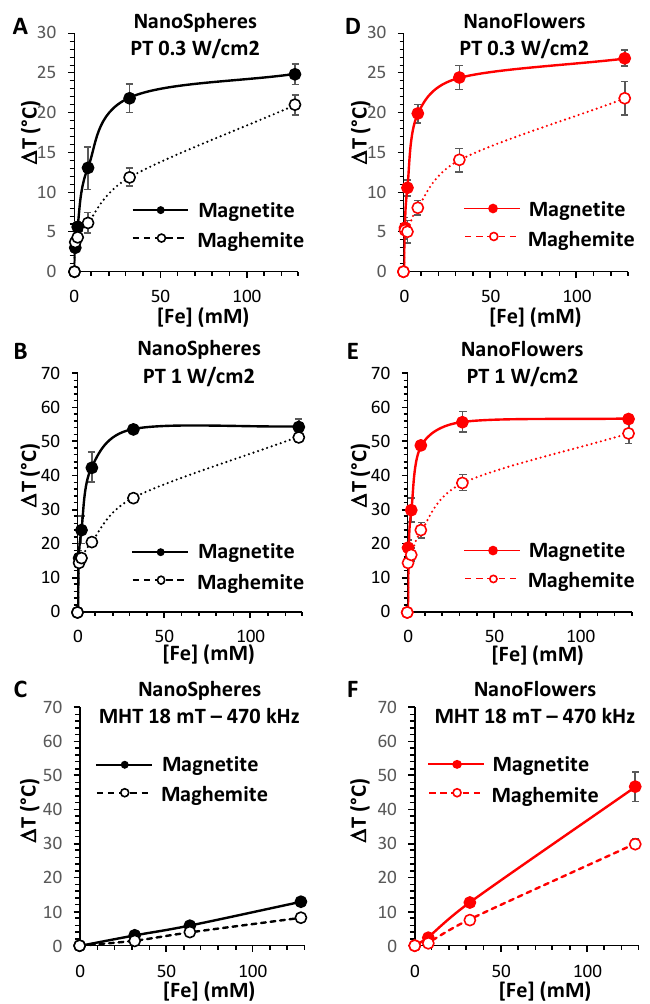
Figure 3. MNP heating performances in water for the PT and MHT heating modalities. Temperature elevation profiles for nanospheres ( A – C ) and nanoflowers ( D – F ) irradiated with a 1064 nm laser at a power density of 0.3 W cm − 2 ( A , D ), 1 W cm − 2 ( B , E ), and exposed to alternating magnetic fields at 18 mT and 470 kHz ( C , F ), according to their concentration, ranging from 0.5 to 168 mM of Fe. All the MNPs are studied in their magnetite (full dotted lines) and maghemite (empty dotted lines) forms. ◦ The highest temperature increase (T) measured was in the range of 50 to 60 C, reached only for magnetite nanoflowers for MHT at the highest concentration (128 mM of Fe), and reached for all the − 2 nanoparticles for PT at 1 W cm at this concentration. The striking di ff erence in PT corresponds to